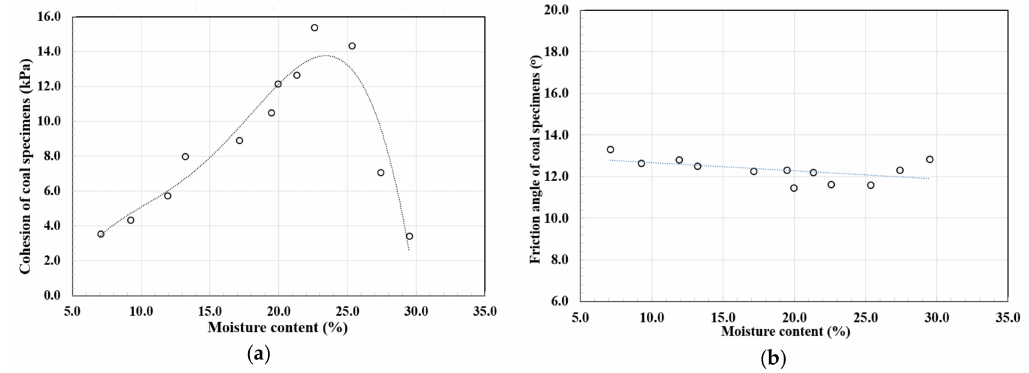
Figure 7. E ff ect of moisture content on the strength properties of coal samples: ( a ) E ff ect on cohesion; ( b ) e ff ect on the friction